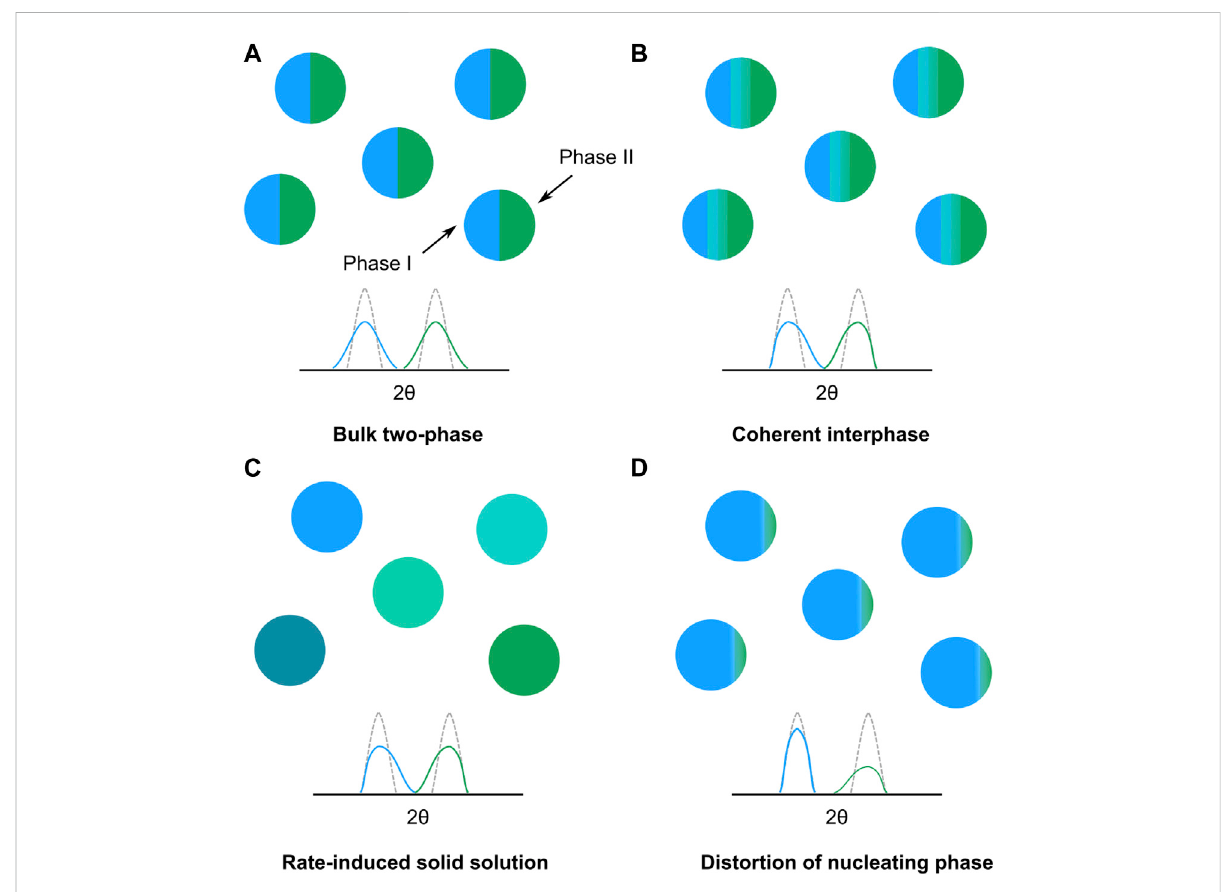
FIGURE 6 Illustration of different phase transition mechanisms during (de)lithiation and their qualitative impact on the observed diffraction peak pro fi les; (A) bulk two-phase mechanism, (B) two-phase mechanism with coherent interface, (C) rate-induced solid solution in individual crystallites and (D) distortion of a nucleating